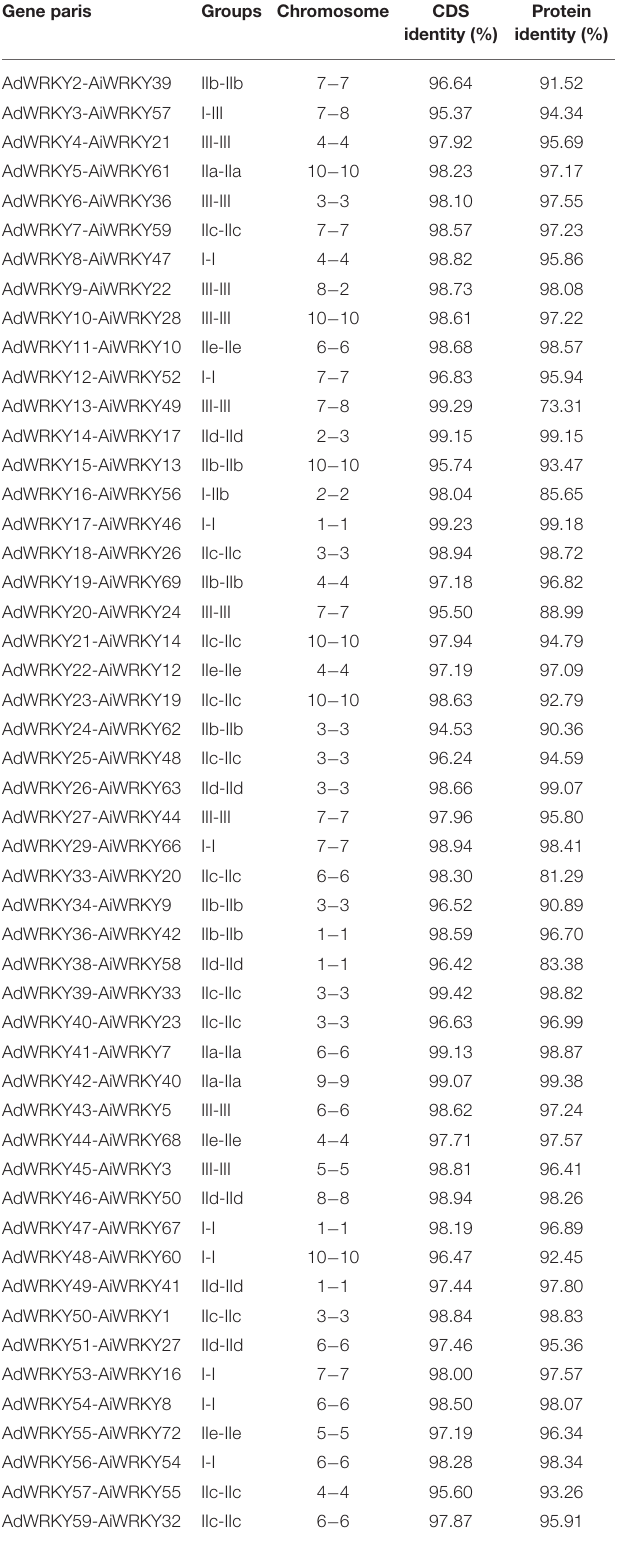
TABLE 2 | The information of orthologous genes in AdWRKY and AiWRKY . Gene paris Groups Chromosome CDS